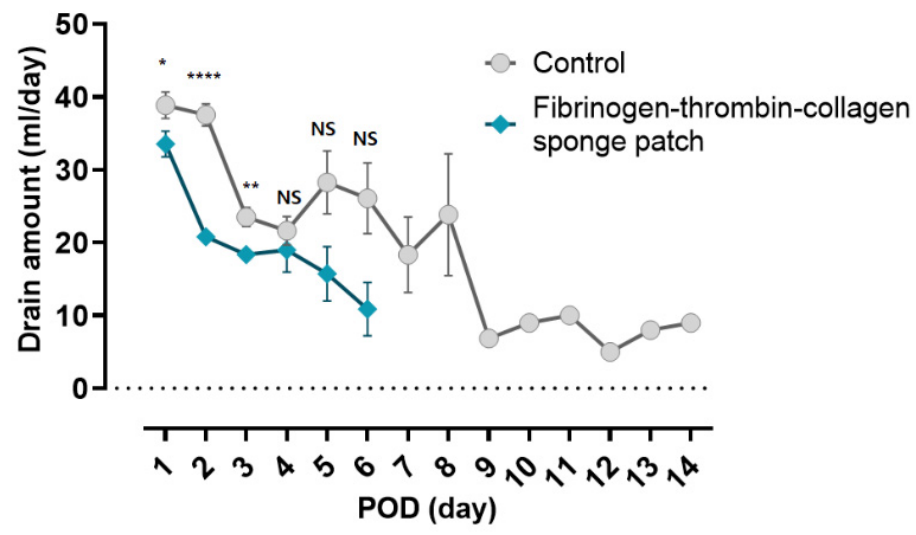
Figure 3. Comparison of the postoperative daily drain amount between the control group and the fibrinogen-thrombin-collagen sponge patch group. Dots represent the mean drain amount during hospitalization. Error bars represent standard errors. POD, postoperative day. NS, not significant; * p < 0.05; ** p < 0.01; **** p < 0.0001.